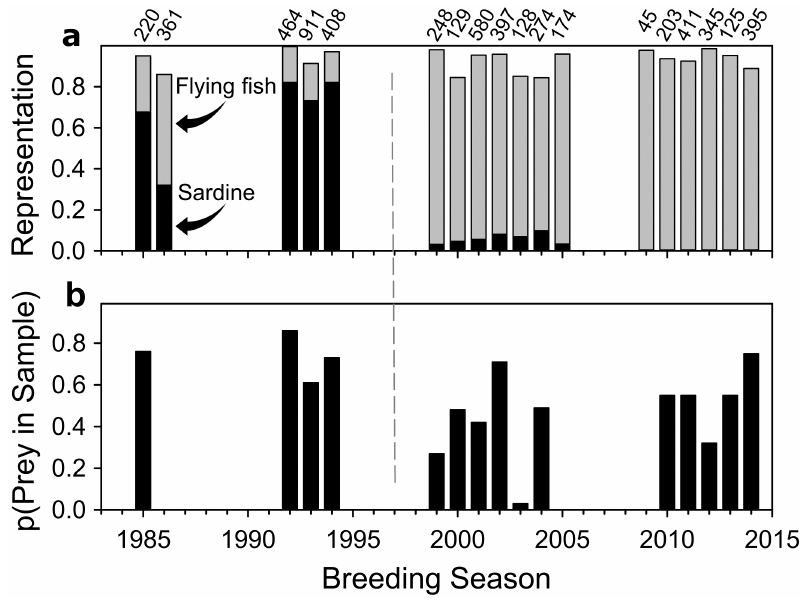
Fig 1. Temporal change in diet of Nazca boobies. (a) Numerical representation of the two major prey types in systematic and opportunistic regurgitation samples. Missing years due to permit restrictions (mid-2000s) or to lack of data (1980sand mid-1990s; sardines (black fill) dominatedcasual observations duringthese gaps until the 1997–98 El Ni ñ o event [dashed line] but data not recorded).# prey items at top of bar. Breeding spans two calendaryears (October-May), “breedingseasons” are labelledby the first year in each two-year spread. Black and gray bars do not sum to 1.0 becausesardines and flying fish are not the only prey types in the diet. (b) Probabilityof a bird producing at least one prey item in 1,345 systematic regurgitation samples collectedin January-April (probability is lower after 1997–98;Mann-Whitney U Test, N 1 = 4, N 2 = 11, Z = 2.48, P = 0.01; see S1